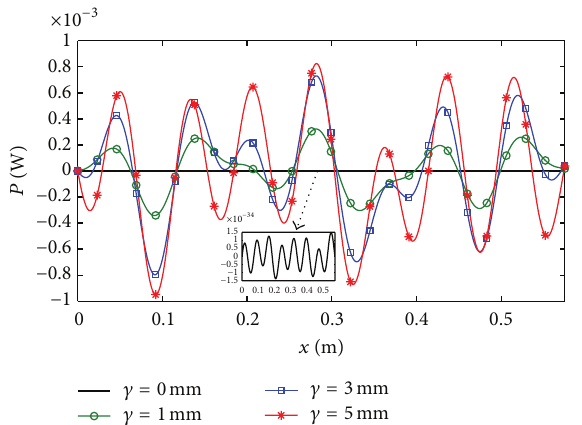
Figure 7: Vibration power flow of the FRM with FRJ and ERJ under disturbance